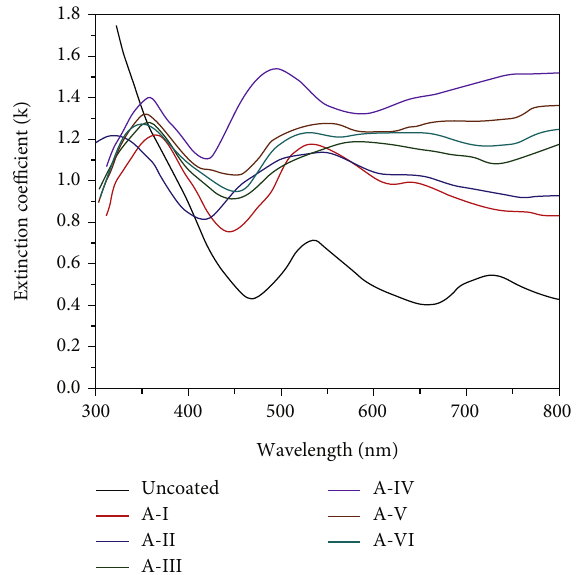
Figure 5: Extinction coe ffi cient of various MoS